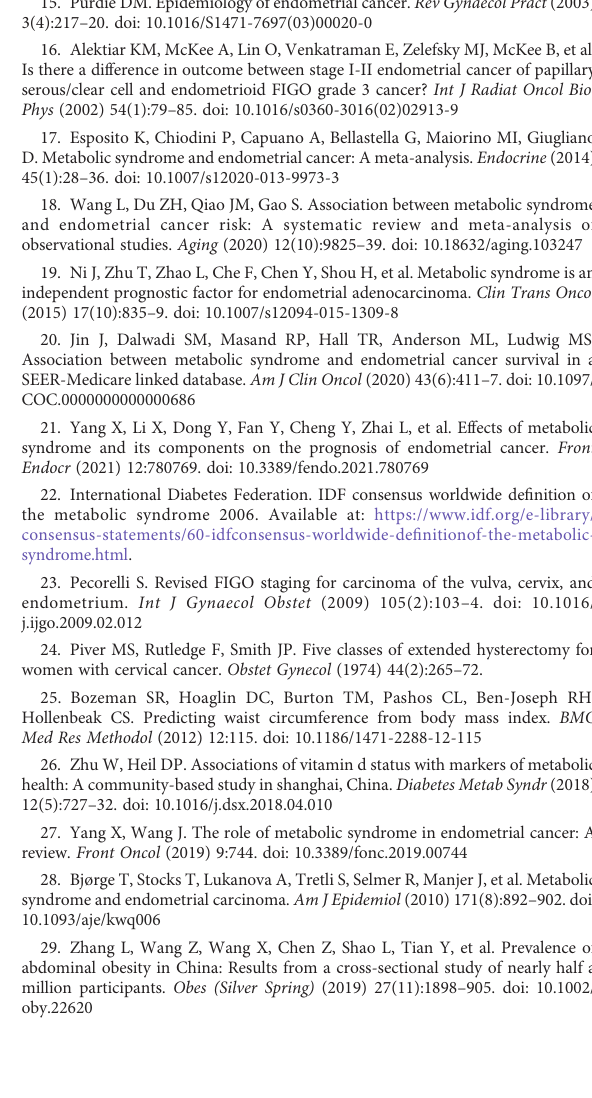
used in this study. In the fi gure, the original values of waist circumference are presented in black, and the predicted values are presented in red, using the prediction model: Waist circumference (cm) = 2.20730 × BMI (kg/m2) + 0.16377×Age(years)+22.23815. BMI, body massindex.